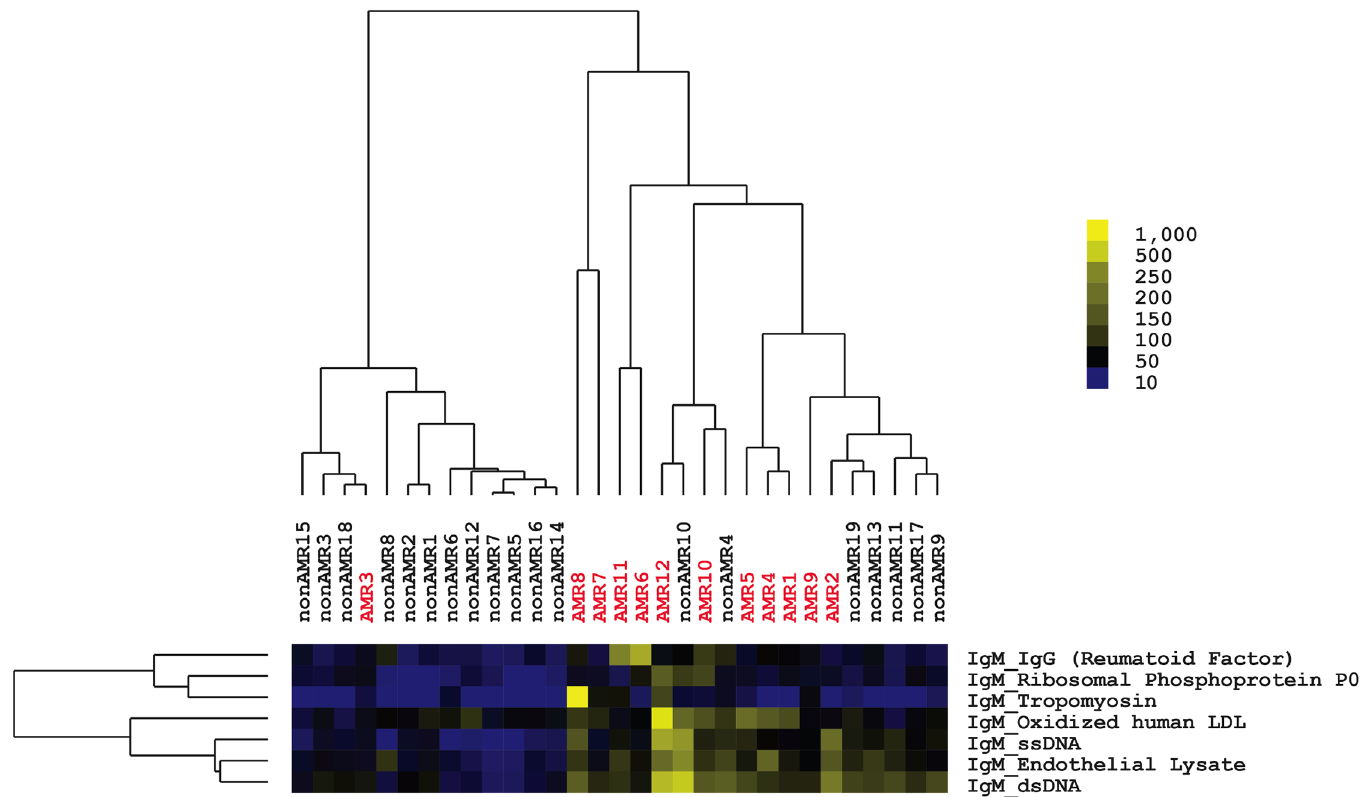
Fig 6. Heatmap of non-HLA reactivities that are significantly higher in post-transplant serum of AMR patients compared with non-AMR patients. Significance analysis of microarrays identified seven antigen reactivities that are higher in recipients with AMR compared with non-rejectors. Yellow squares in the heatmap indicate a higher reactivity, whereas blue squares indicate a lower reactivity as shown in scale. Recipients with AMR are labeled in red and are numbered 1 – 12. Non-rejectors are labeled in black and numbered 1 – 19. Results are representative of two independent array experiments. ssDNA, single-stranded DNA; dsDNA, double-stranded